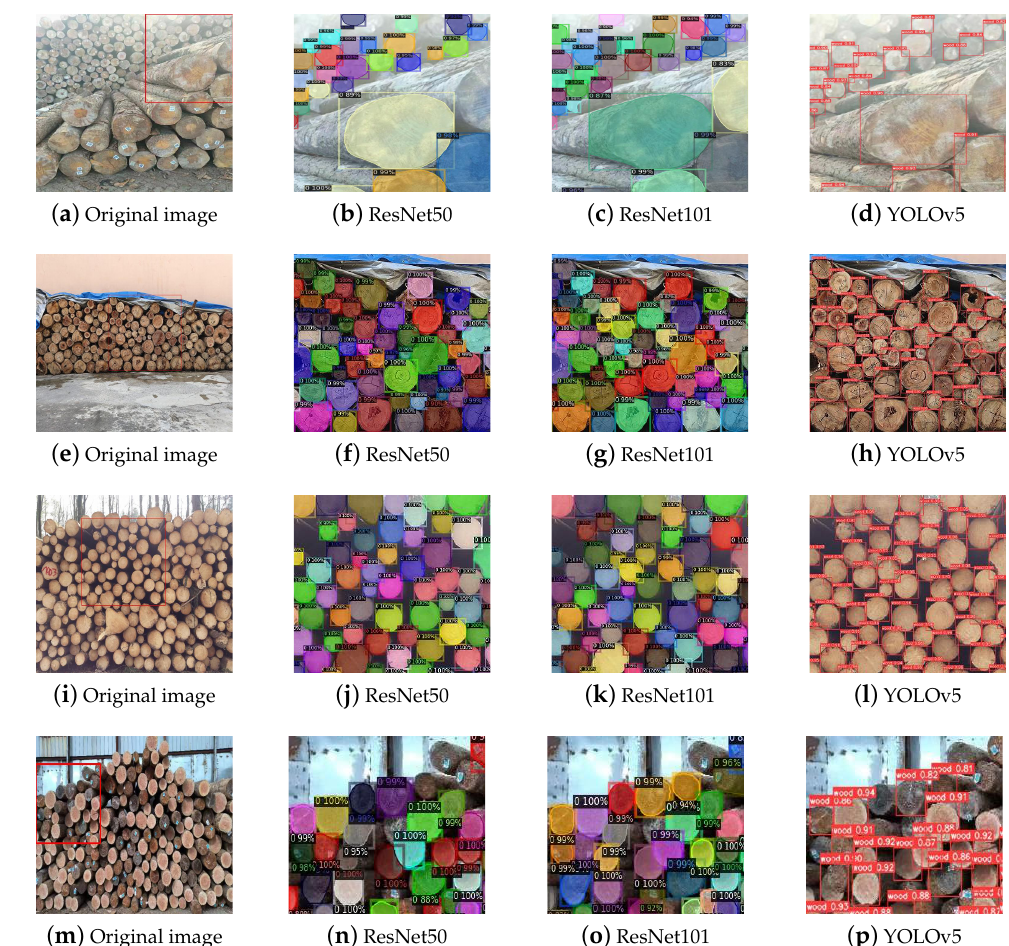
Figure 10. Different detect images.ResNet50, ResNet101 denote the different backbone networks used by Mask